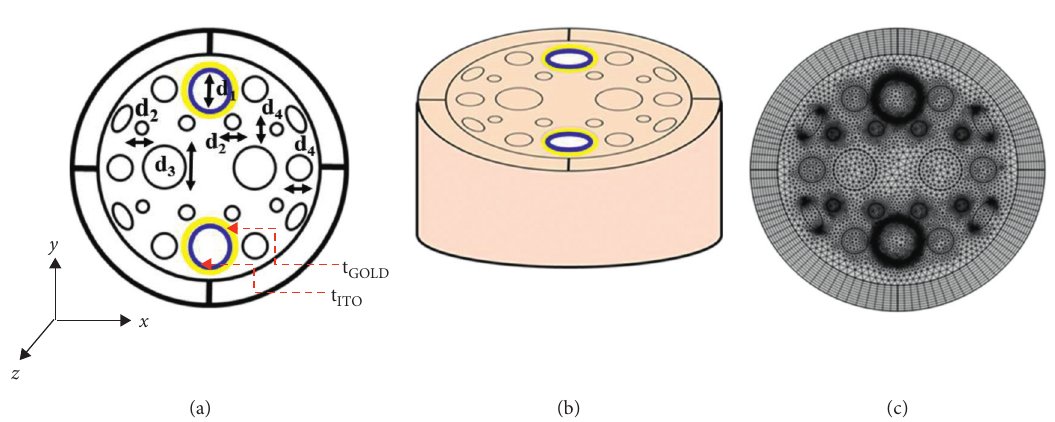
Figure 1: (a) A sectional view of the plasmonic PCF filter. (b) A three-dimensional representation. (c) The finite element mesh of the proposed filter.